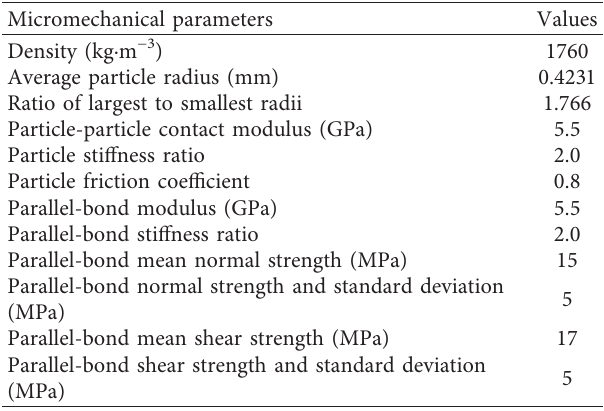
Table 2: Mesoscopic physics-mechanical parameters of coal